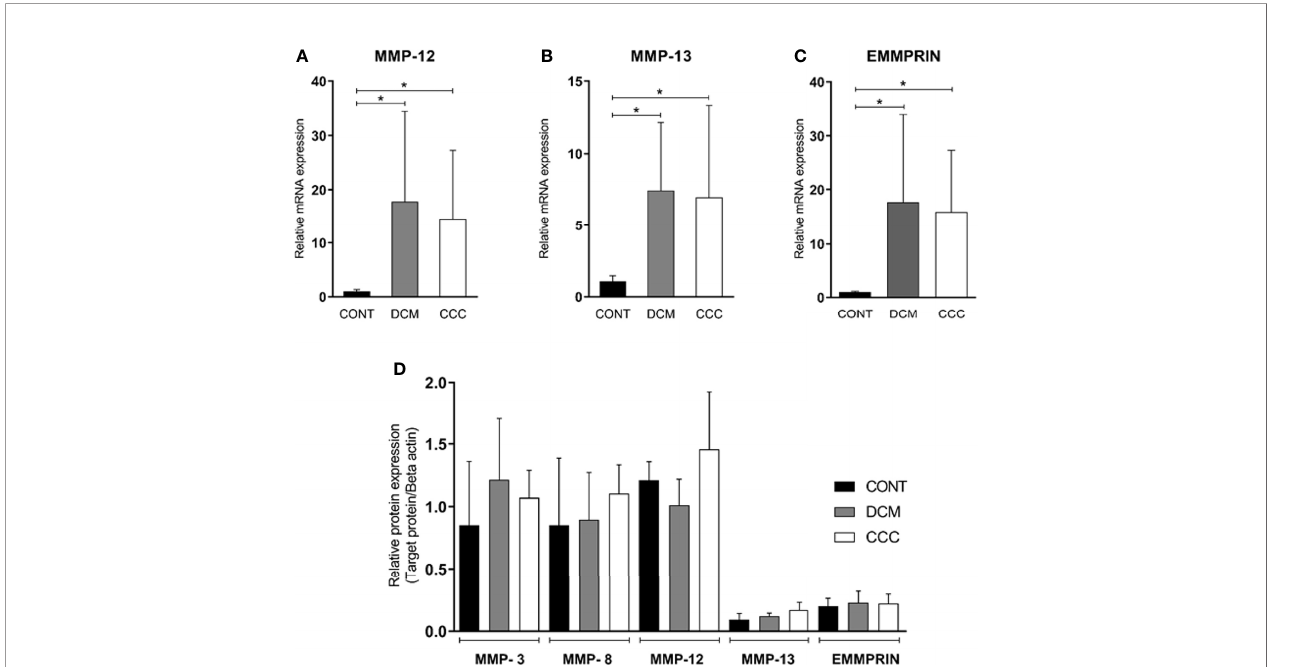
FIGURE 3 | Expression of MMP-3, MMP-8, MMP-12, MMP-13 and EMMPRIN in heart tissue from CCC and DCM samples. Myocardial expression of MMP-12, MMP- 13 and EMMPRIN mRNA. Real-time PCR analysis of mRNA expression in control (n = 6), DCM (n = 12) and CCC (n = 17) myocardium. The expression was calculated as the mean ± SD for each group as individual data points using the relative expression (fold change over control) by 2 − DD Ct method, normalized with the endogenous gene RPL0, as described in the Materials and Methods section. (A) Relative expression of MMP-12 mRNA. (B) Relative expression of MMP-13 mRNA. (C) Relative expression of EMMPRIN mRNA. The expression of mRNA of MMP-3 and MMP-8 was undetectable in all samples tested (data no show). (D) Densitometry analysis of the MMP-3, MMP-8, MMP-12, MMP-13, and EMMPRIN. Groups were compared by a non-parametrical test (Mann – Whitney Rank Sum Test) with GraphPad Prism software (version 6.0; GraphPad). Results were expressed as mean ± SD. *P -values were considered signi fi cant if p-value (0.05) corrected for multiple comparisons by Bonferroni ’ s method (corrected p-value = 0.05/3 =